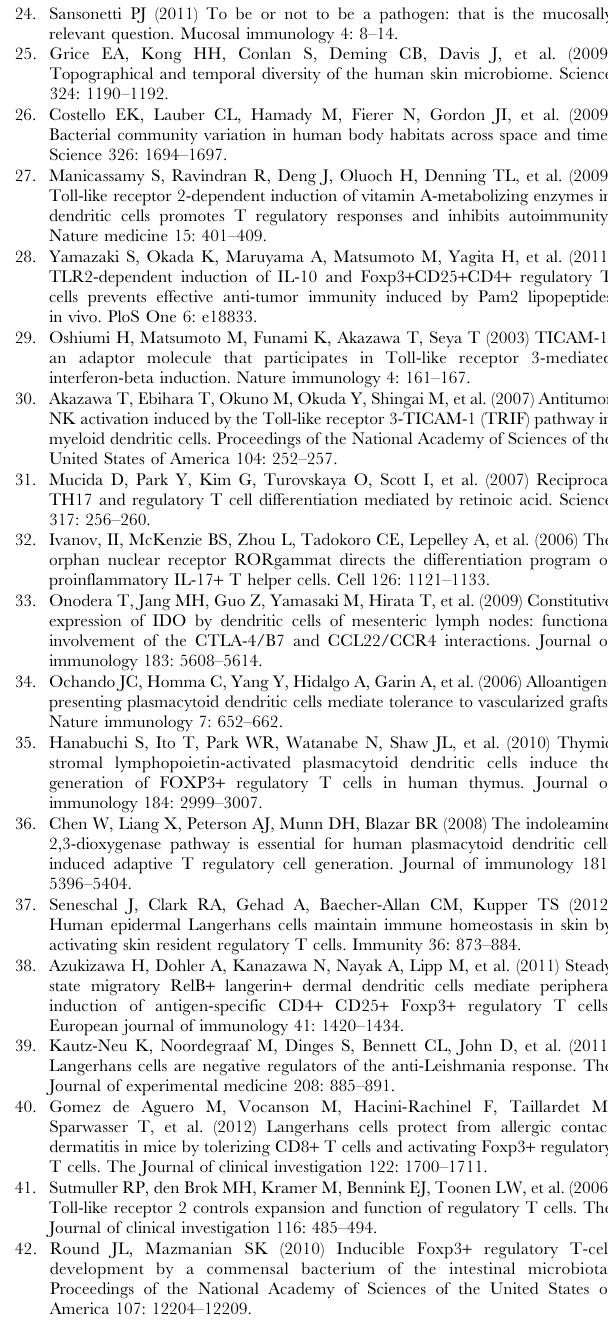
shown. (B) As in (A), but the frequency of CD25 + or CD25 2 Foxp3 + T-regs/CD4 + T cells were shown. (TIF) Figure S2 The frequency of CD11c + DC is similar between CLN and ALN. (A) CLN or ALN from one B6 mouse were digested by collagenase and stained with anti-CD11c and CD8 Abs. Representative of 5 separate experiments is shown. (B) The frequency of CD11c + cells/total LN cells in one mouse is shown. A summary of 5 separate experiments. P value provided is by paired t-test. ‘‘n.s.’’= ‘‘not significant’’.